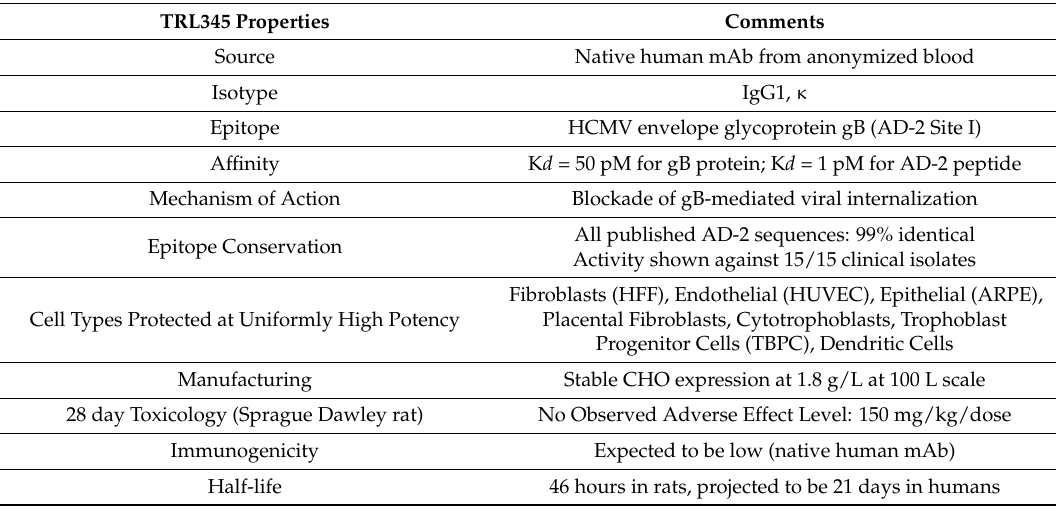
Table 2. Properties of